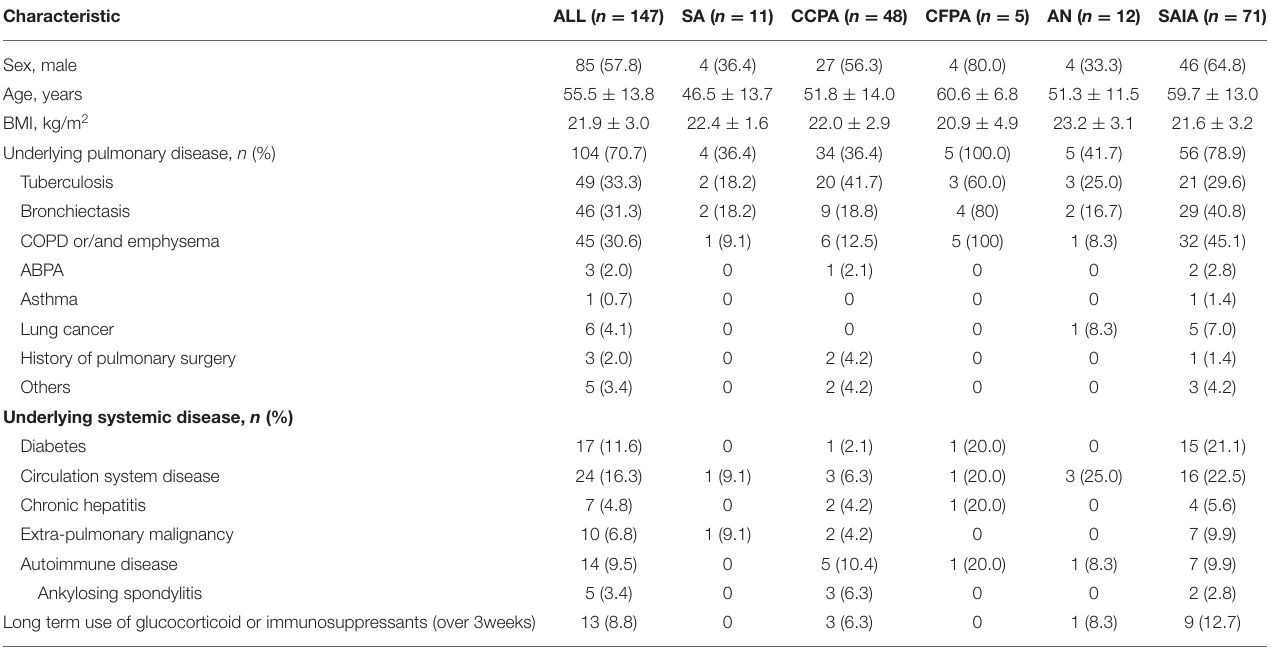
TABLE 1 | Baseline characteristics of patients with chronic pulmonary aspergillosis (CPA) in different subtypes.